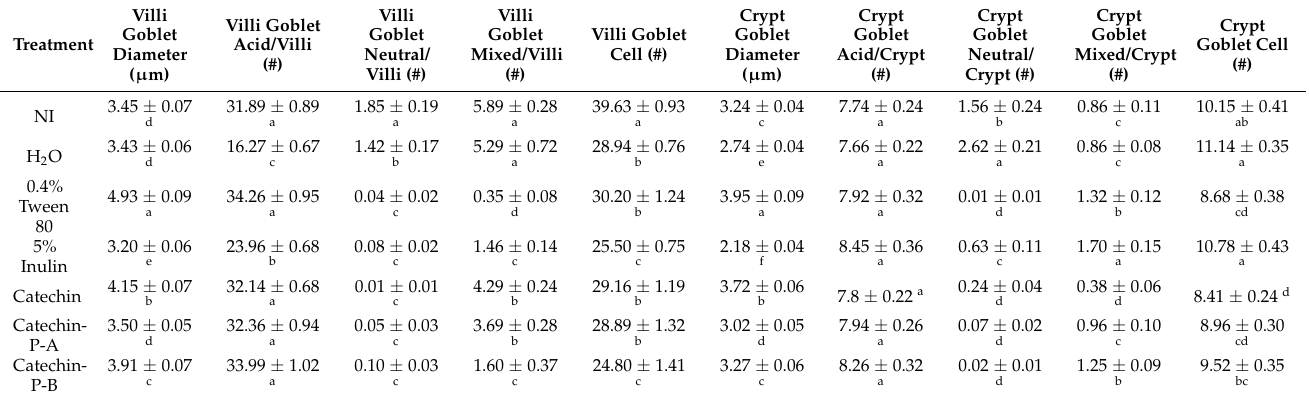
Table 4. Effect of the intra-amniotic administration of experimental solutions on the goblet cells 1